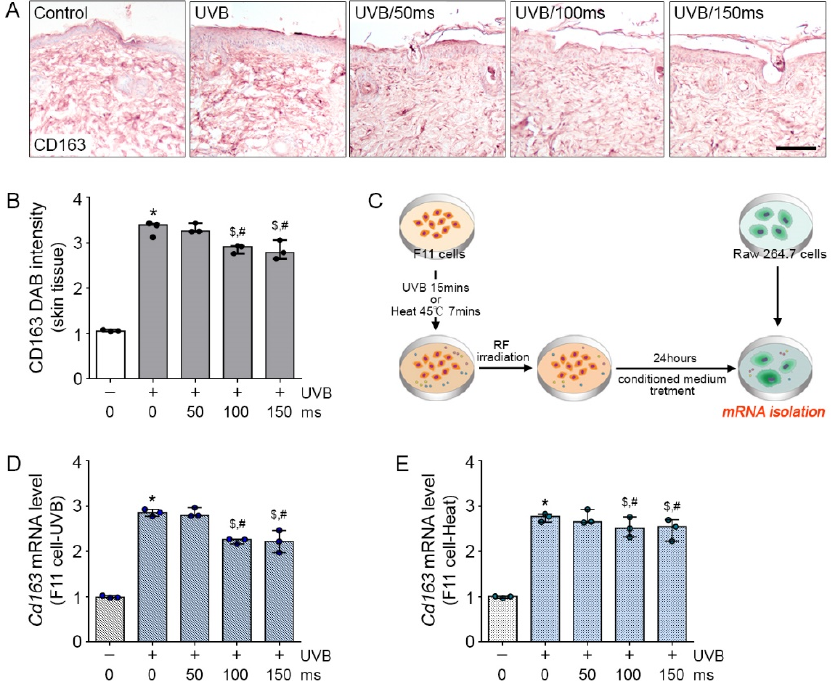
Figure 3. Inhibitory effects of RF on neuropeptide-induced macrophage activation in UVB-exposed mice skin and UVB- or heat-treated sensory neuronal cells. ( A , B ) The CD163 expression level was analyzed by immunohistochemistry. Scale bar = 100 µm; (3 mice per group) ( C ) The cell experimental scheme for Raw264.7. affected by F11 cells; ( D , E ) mRNA expression of the Cd163 by qRT-PCR in UVB-CM exposure Raw264.7 cell model ( D ) and heat-CM exposure Raw264.7 cell model ( E ) and were normalized to that of Actb and expressed relative to the control group. * p < 0.05 vs. Control; $ p < 0.05 vs. UVB-CM or Heat-CM; # p < 0.05 vs. RF 50 ms.